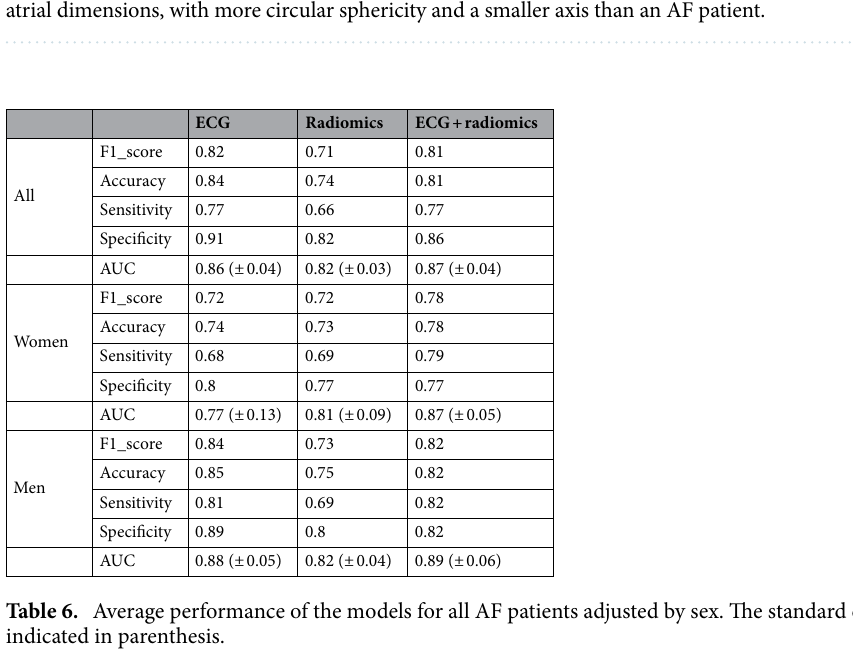
Table 6. Average performance of the models for all AF patients adjusted by sex. The standard deviation is indicated in parenthesis.